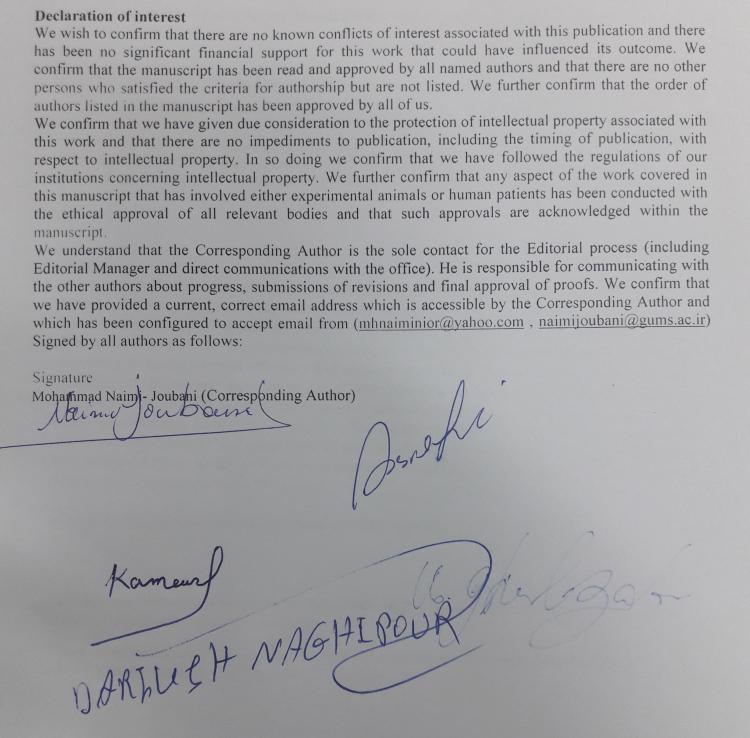
The core spectra of the chips’ surfaces after APTES and GO-COOH coating.